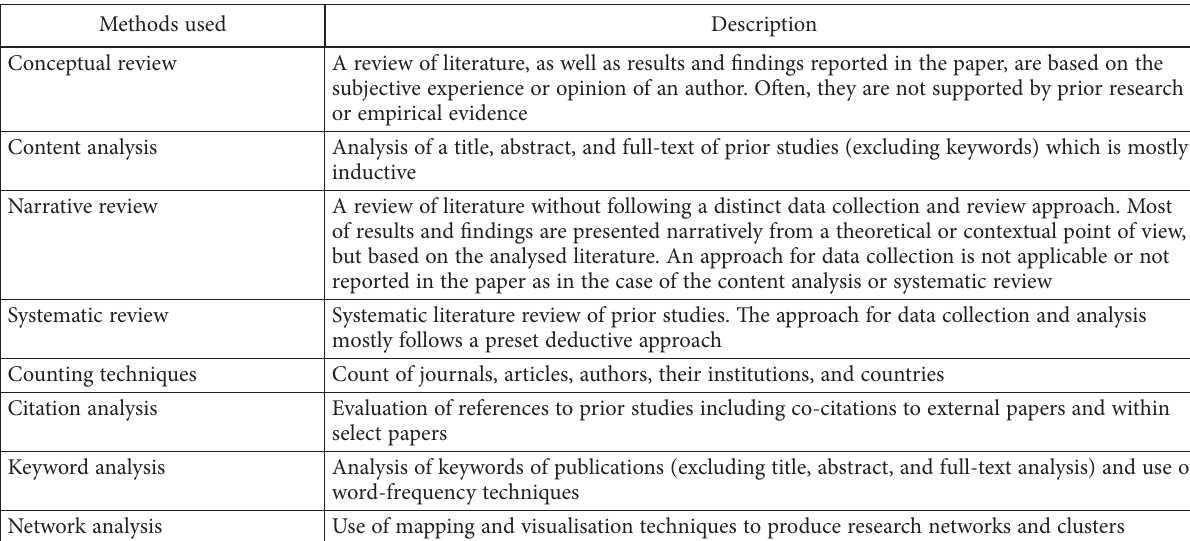
Table 3. Methods used by the literature review studies in